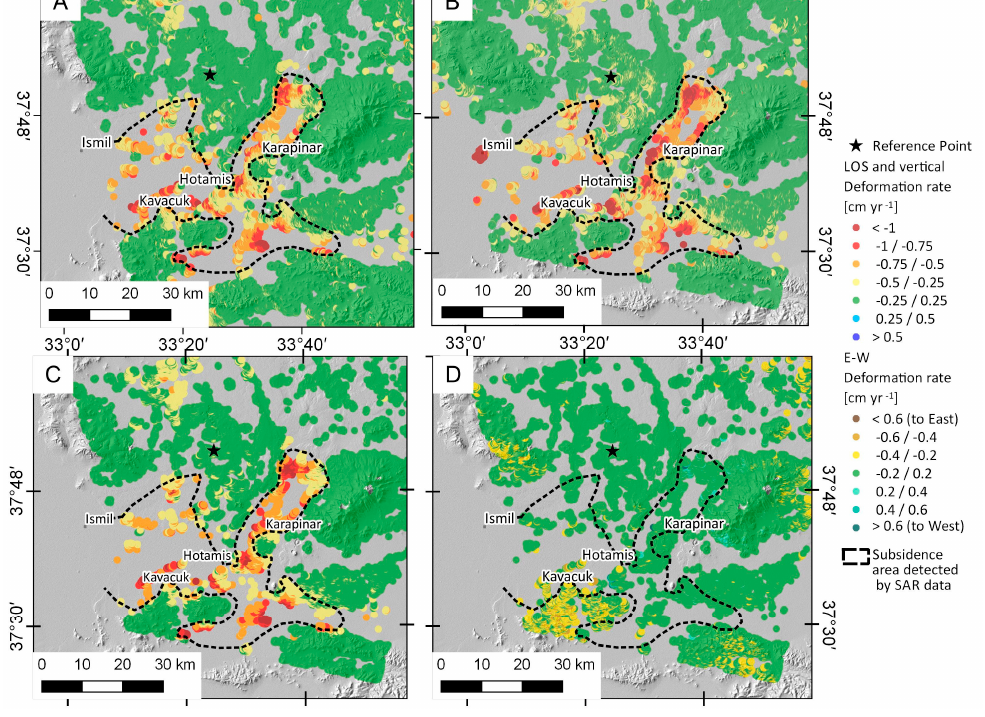
Figure 4. SBAS-DInSAR deformation rate maps of the study area, superimposed on hill shade image derived from DEM. Maps have been produced by processing ENVISAT data acquired in the December 2002–July 2010 time interval. ( A , B ) show displacements measured along the satellite LOS direction during ascending and descending passes, respectively; ( C , D ) show displacement components computed along the vertical and (E-W) horizontal directions, respectively. Black dashed line represents the contour of the DInSAR derived subsidence area. Maps showing rates and spatial pattern of surface deformations observed from both satellite orbits (i.e., descending and ascending) are reported in Figure 4A,B. Displacements are measured along the LOS of the satellite: negative values (yellow to red color) represent movements away from satellite (i.e., land subsidence) whereas positive values (cyan to blue) represent movements towards the satellite (i.e., land uplift). Green-color pixels are characterized by velocities within the range of ± 0.25 cm/year and are considered stable. DInSAR measurements are related to a reference point located in an area assumed to be geologically stable, thus not susceptible to subsidence processes (for location see black star in Figure 4). The achieved results show an accuracy of 0.8 cm for the displacements and 0.15 cm/year for the deformation rate.